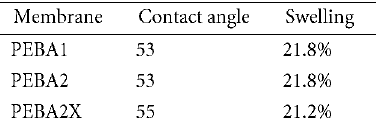
Table 2. Contact angle and swelling of composite membranes.